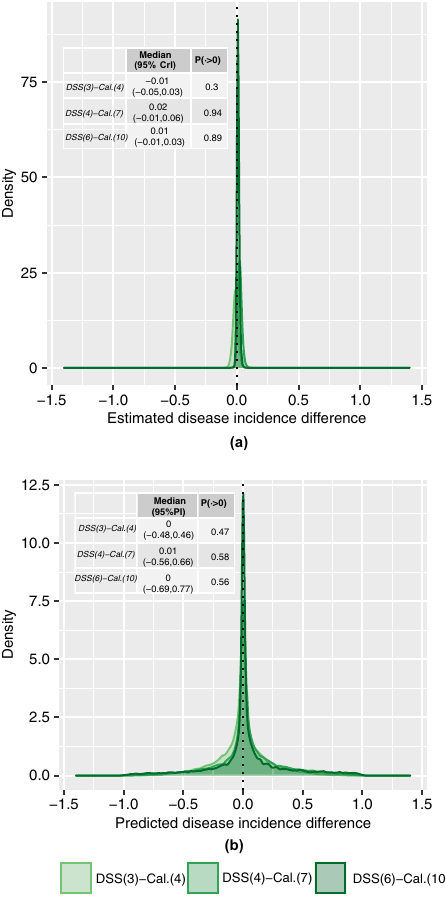
Fig. 3 Probability distributions of differences in disease incidence between DSS-based (DSS) and calendar-based (Cal) strategies considering different observed numbers of sprays. While ( a ) describes the distributions of the expected differences across the experiments included in the dataset, ( b ) describes the plausible difference values predicted for a new, not yet conducted, experiment. In each case, three distributions are reported, corresponding to the fi rst (Q 1 ), second (median) (Q 2 ) and third (Q 3 ) quartiles of the observed numbers of sprays for DSS (3, 4 and 6) and Cal (4, 7, and 10) strategies in the 80 experiments. Each probability distribution is summarised by its median, 95% probability interval and probability of the differences being positive. CrI and PI mean credibility and predictive intervals, respectively. P (>0) indicates the probabilities of the differences being positive. All credibility probability intervals include zero, thus revealing that the use of lower numbers of sprays resulting from the DSS strategies does not lead to a substantial increase in disease incidence.